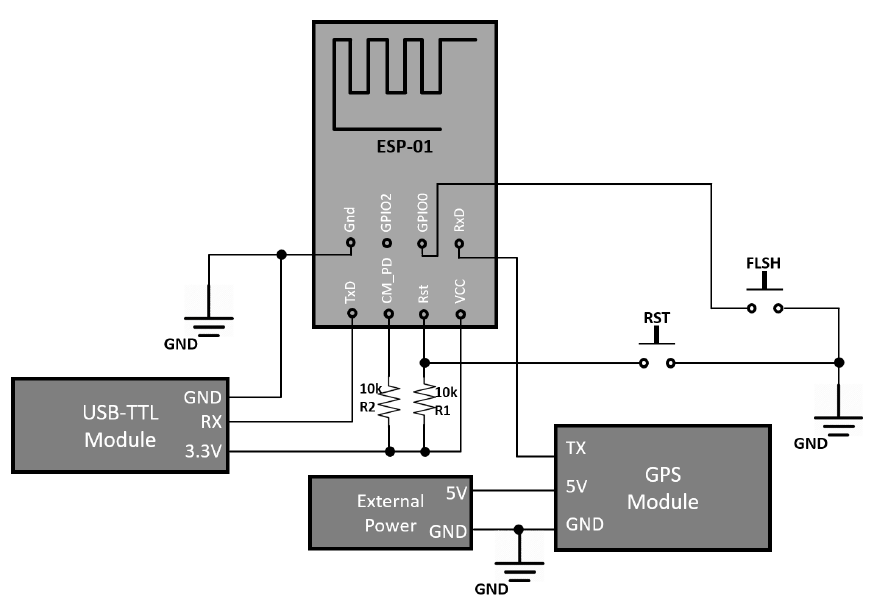
Figure 12. NOVA-WiFi-Client (NWC) prototype